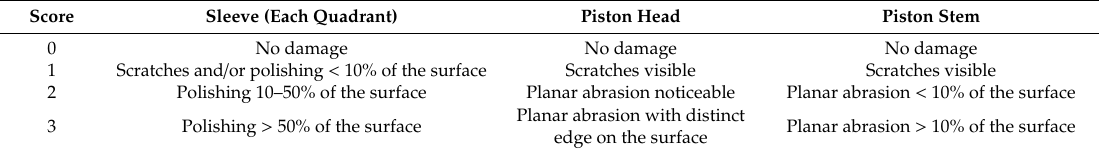
Table 1. Criteria for the determination of the coupling wear score.